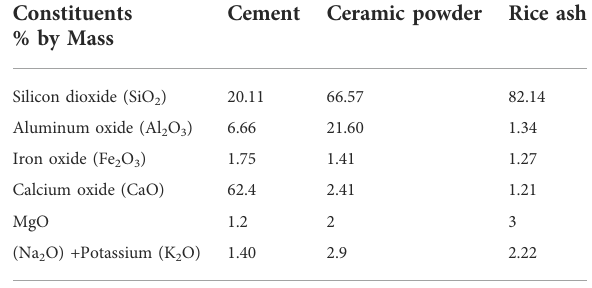
TABLE 2 Chemical composition of cement, CWP, and RHA.